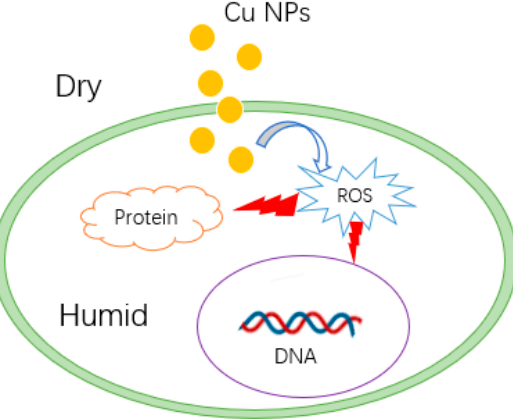
Figure 6. Possible contact killing mechanism of Cu nanoparticles (NPs).